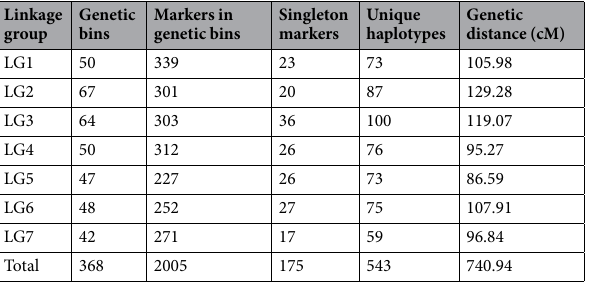
Table 1. Summary of the SNP-based linkage map of Lens ervoides L01-827A × IG 72815 RIL (F 9 )